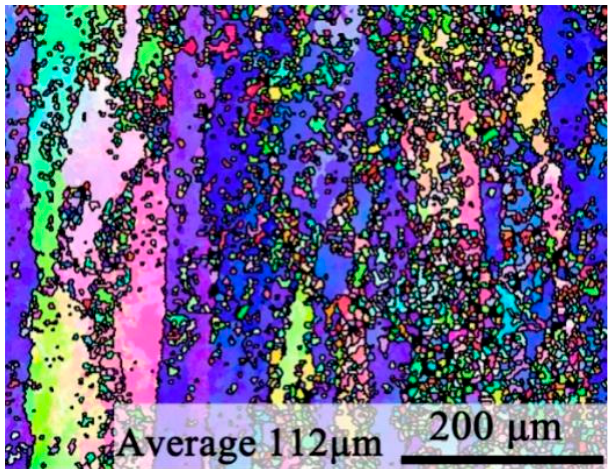
Figure 10. Microstructure after heat treatment (480 °C × 1 h solid solution and 120 °C × 24 h aging).